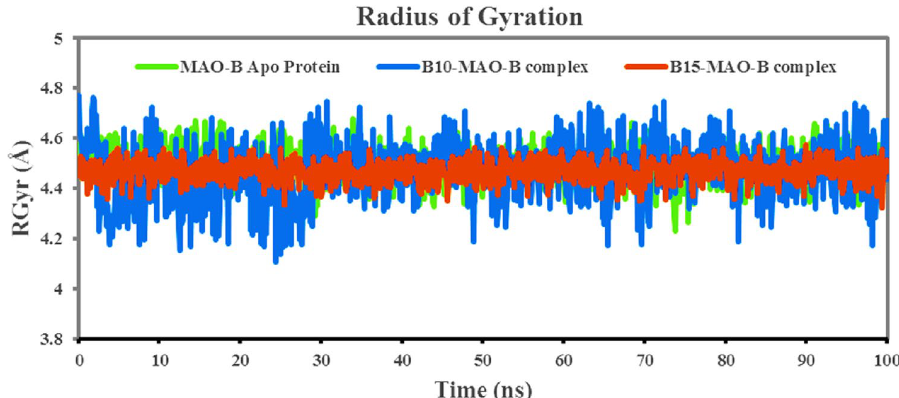
Figure 8. The time-dependent RGyr of B10 -hMAO-B (blue) and B15 -hMAO-B (red) complexes during 100 ns simulations.